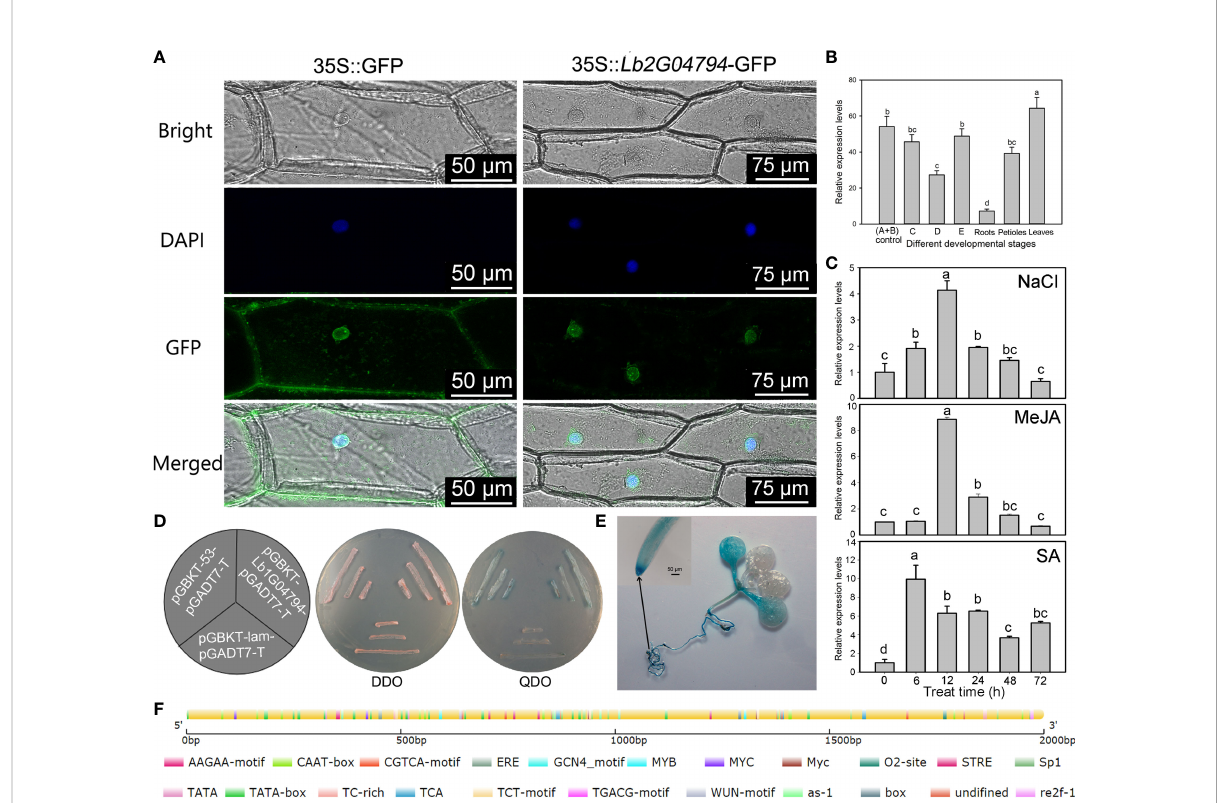
FIGURE 1 Expression pattern of Lb1G04794 and subcellular localization of its encoded protein. (A) Subcellular localization of the protein encoded by the unknown gene Lb1G04794 in onion epidermal cells transiently transformed with 35S : Lb1G04794 - GFP via Agrobacterium. pCAMBIA 1300-35S- sGFP ( 35S:GFP ) was used as an empty control vector. Scale bar, 100 µm in 35S:GFP , 250 µm in 35S : Lb1G04794 - GFP . (B) Expression of Lb1G04794 in L. bicolor at different developmental stages. Stage A, undifferentiated, 4 – 5 days after sowing; stage B, salt gland differentiation, 6 – 7 days after sowing; stage C, stomatal differentiation, 8 – 10 days after sowing; stage D, epidermal differentiation, 11 – 16 days after sowing; stage E, mature, more than 17 days after sowing. Old leaves, >20 days old; petiole, base of stage-E leaf; root, root of stage-E seedling. Data are means of three replicates ± SD; different lowercase letters indicate signi fi cant differences at P = 0.05 according to Duncan ’ s multiple range test. (C) Changes in Lb1G04794 expression levels under different treatments: NaCl, MeJA, and SA for 6, 12, 24, 48, and 72 h. Data are means of three replicates ± SD; different lowercase letters indicate signi fi cant differences at P = 0.05 according to Duncan ’ s multiple range test. (D) The protein encoded by Lb1G04794 self-activates when expressed in yeast. Colonies were grown on synthetic de fi ned (SD) medium – Trp – Leu (SD – Trp – Leu) and SD – Trp – Leu – Ade – His+X- a -gal. pGADT7-T+pGBKT7- Lb1G04794 , experimental group; pGADT7-T+pGBKT7-53, positive control; pGADT7-T+pGBKT7-lam, negative control. (E) GUS staining results of the Lb1G04794 promoter driving GUS expression in Arabidopsis transgenic lines (7 days after germination). (F) Schematic diagram of the Lb1G04794 promoter, as predicted using PlantCARE (Lescot et al., 2002 (http://bioinformatics.psb.ugent.be/webtools/plantcare/html/); the map was drawn using CSDS 2.0 (Hu et al., 2015) (http://gsds.gao-lab.org/). Different colors indicate different cis